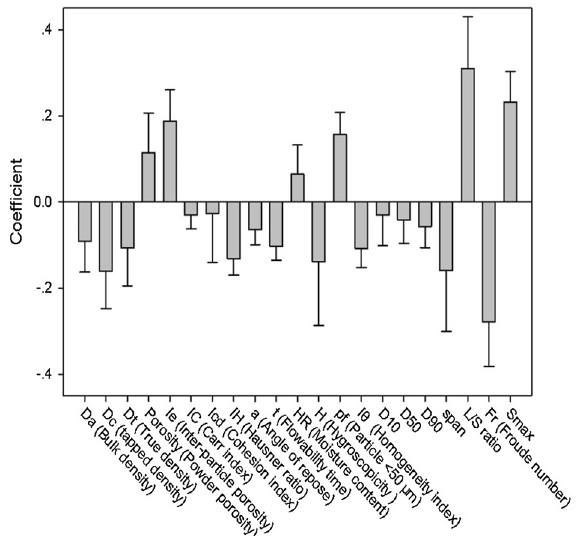
Figure 6. The coefficients plot of PLS Model 2.